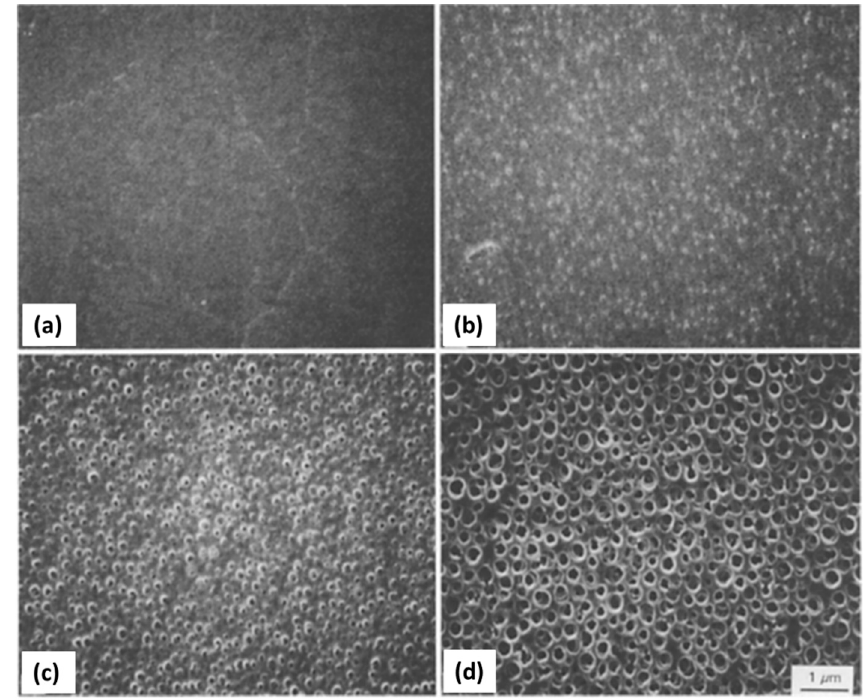
Figure 19. Morphology of TiO 2 thin films prepared with increasing amounts of phase separation inducer, PEO (1800–2200 Mw), and obtained by dip-coating at 100 mm/min withdrawal speed: ( a ) 0 g; ( b ) 0.5 g; ( c ) 1 g; ( d ) 2 g PEO. Reprinted by permission from Springer Nature Customer Service Centre GmbH: Springer, J. Mat. Sci., Morphology of thin anatase coatings prepared from alkoxide solutions containing organic polymer, affecting the photocatalytic decomposition of aqueous acetic acid, Kato K, Tsuzuki A, Torii Y, Taoda H, Kato T, Butsugan Y, ©1995 Chapman & Hall [106].